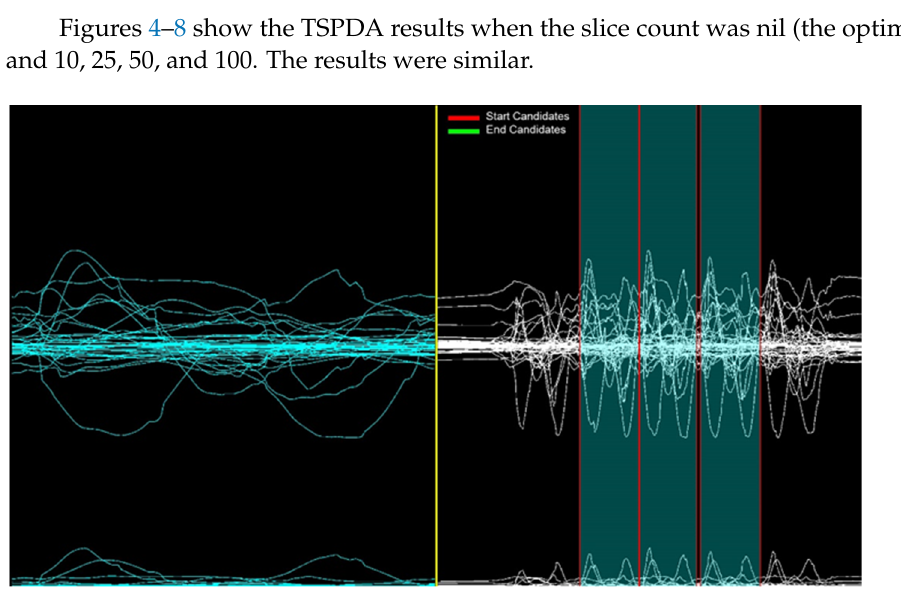
Figure 4. The result in the absence of slice counting.